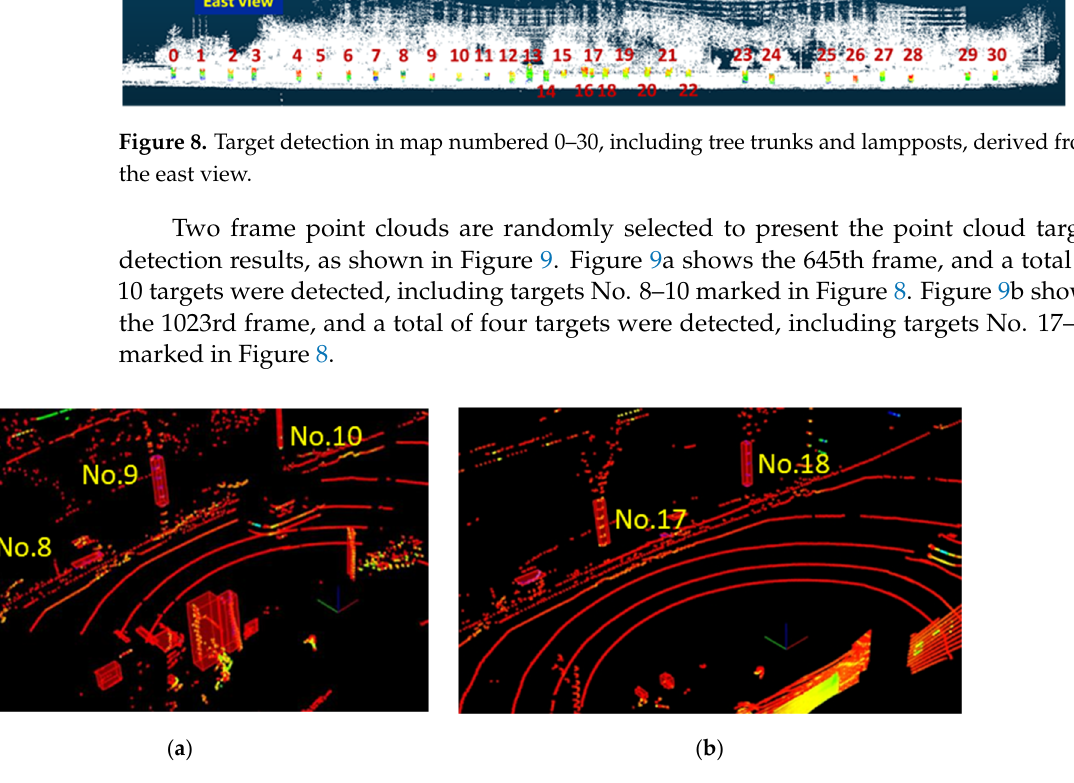
Figure 9. Single frame point cloud target detection. ( a ) The 645th frame and No. 8 – 10 targets in Figure 8. ( b ) The 1023rd frame and No. 17 – 18 targets in Figure 8.